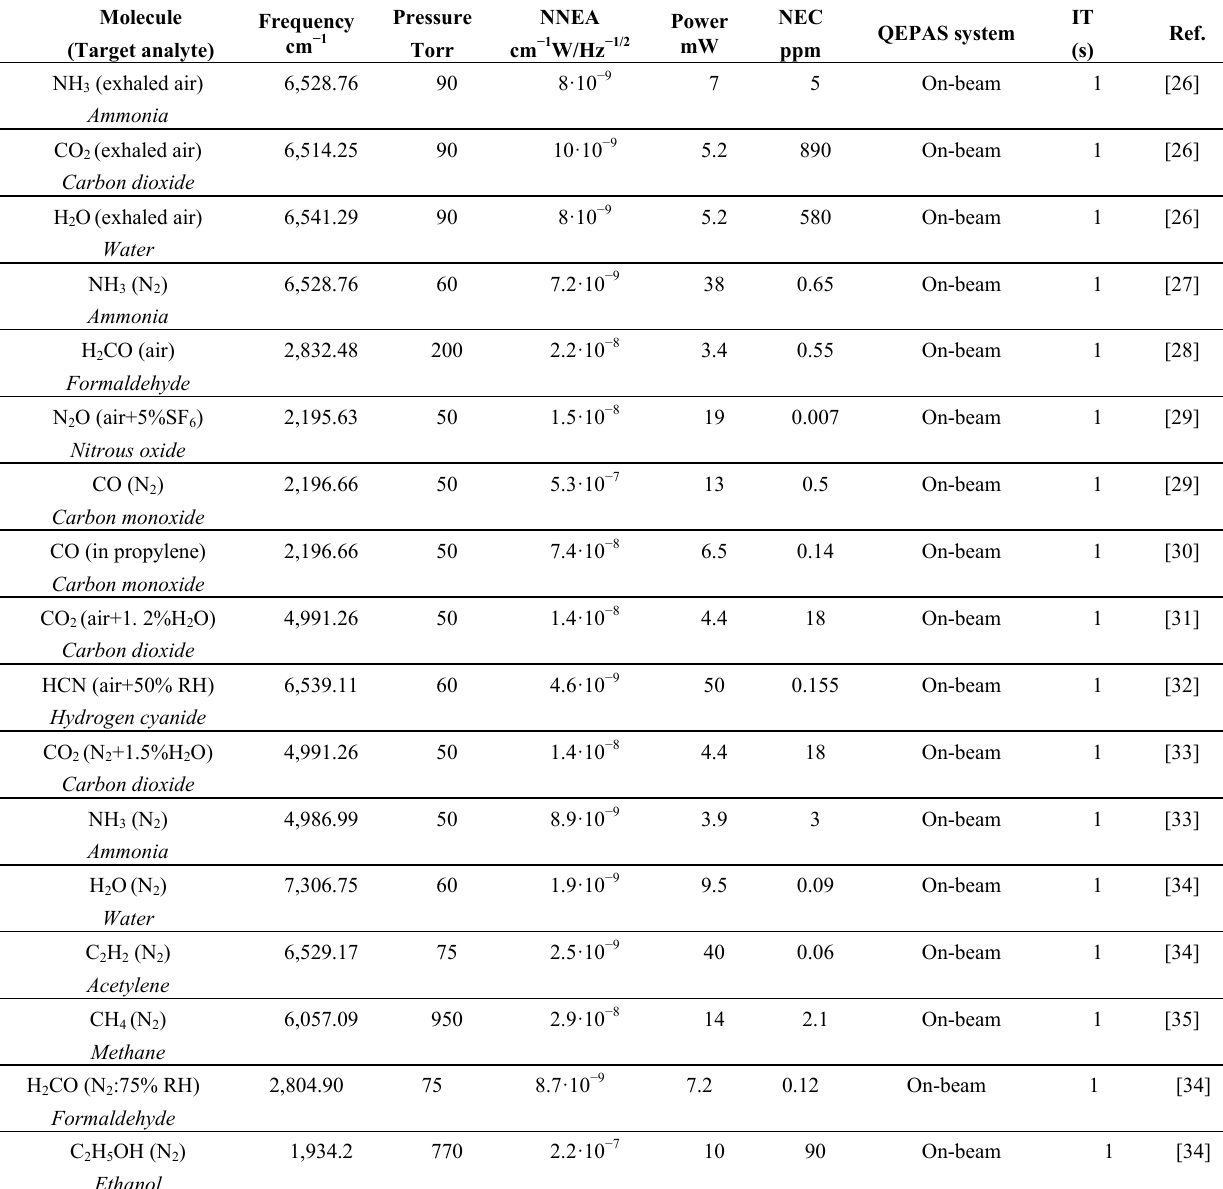
Table 2. QEPAS detection of trace gases using different QEPAS approaches. IT – signal integration